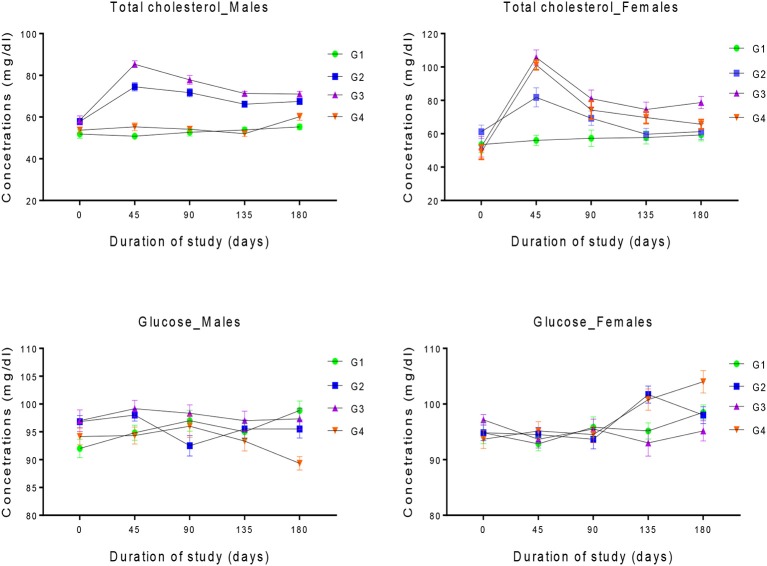
Changes in the levels of serum total cholesterol and Glucose in the four experimental groups of male and female rabbits. group. G1 control group, G2, G3, and G4 represent 20, 30, and 40% GM cottonseed respectively. Two-way ANOVA indicated significant differences between groups, sampling periods and their interaction (P < 0.05). Post-hoc multiple comparisons further revealed significant differences between specific treatment groups and the control groups.